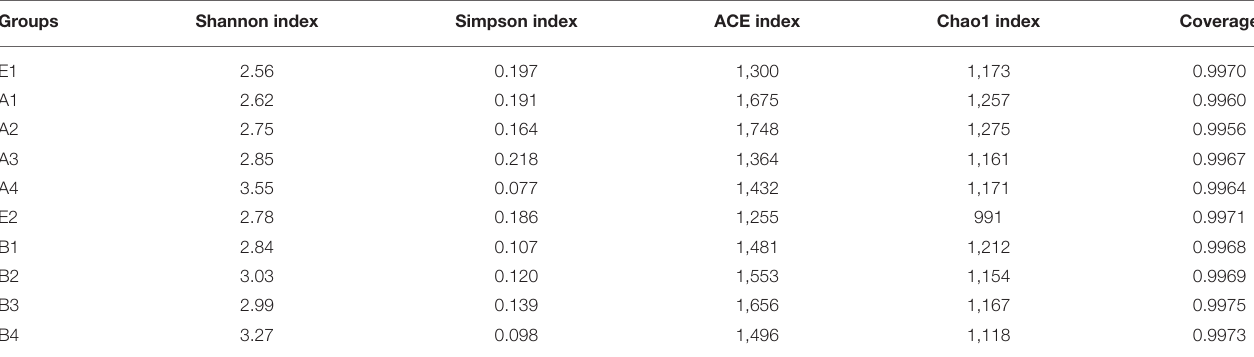
TABLE 7b | Diversity analysis of intestinal microflora in mice.